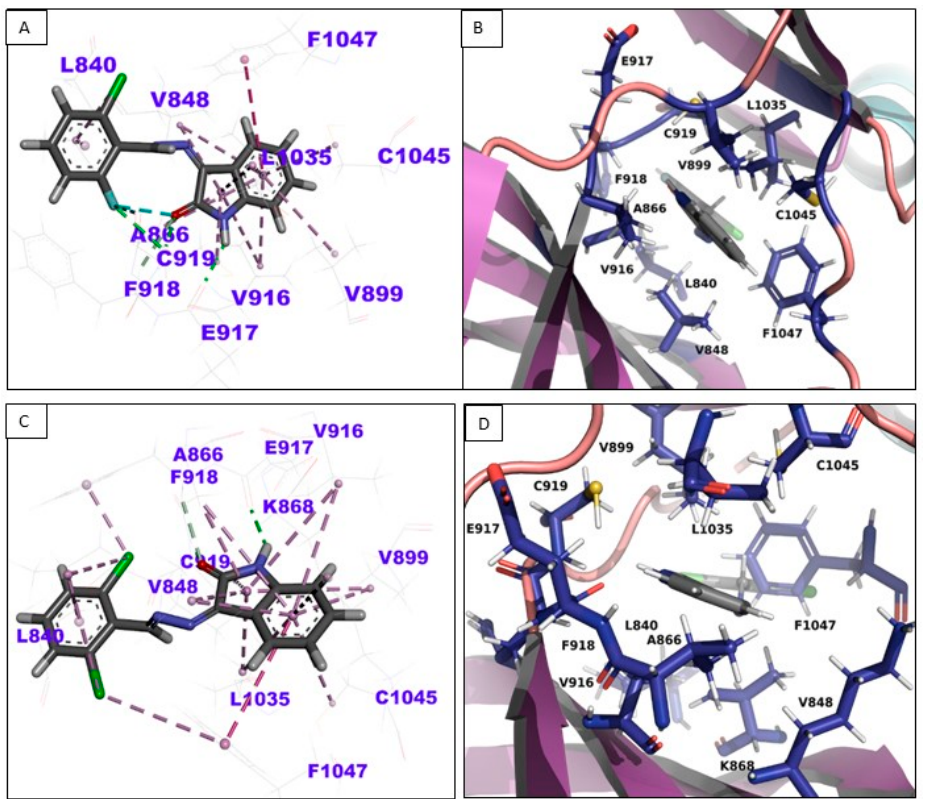
Figure 5. Docking pose of 1 and 2 within the active site of VEGFR-2 protein kinase: ( A ) 2D of 1 ; ( B ) 3D of 1 ; ( C ) 2D of 2 ; ( D ) 3D of 2 .